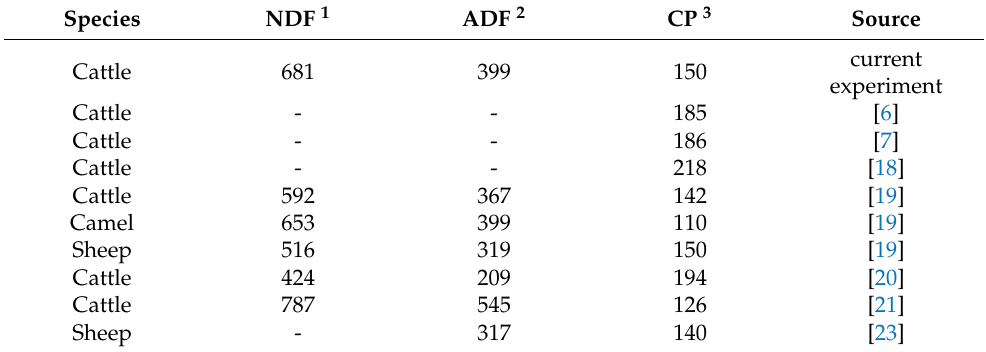
Table 3. A comparison of nutritive value of dried paunch manure from previously published